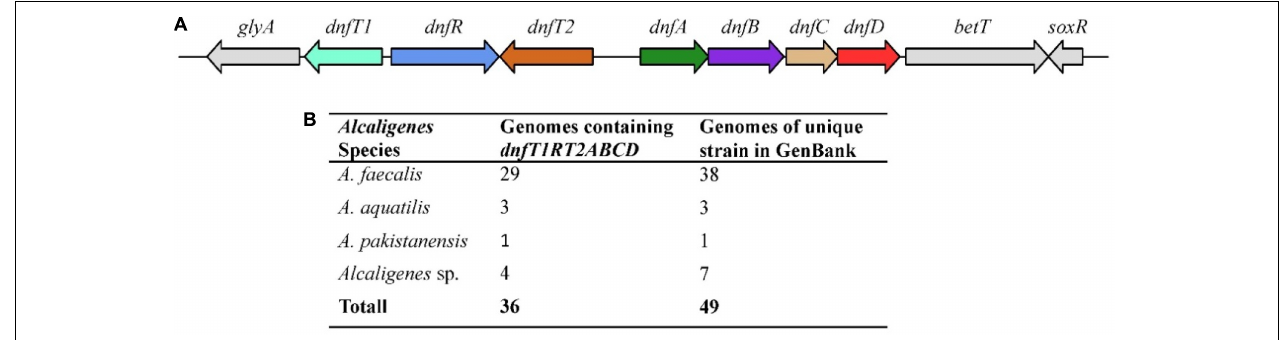
FIGURE 1 | Arrangement (A) and statistics on distribution (B) of dnfT1RT2ABCD among the genomes of the genus Alcaligenes . Here, A. faecalis includes all three subspecies, namely, A . faecalis subsp. faecalis , A . faecalis subsp. Parafaecalis, and A . faecalis subsp. phenolicus . There are 49 genomes of unique Alcaligenes strains in GenBank updated to May 2021, and strain HO-1 was recognized as one of Alcaligenes sp.